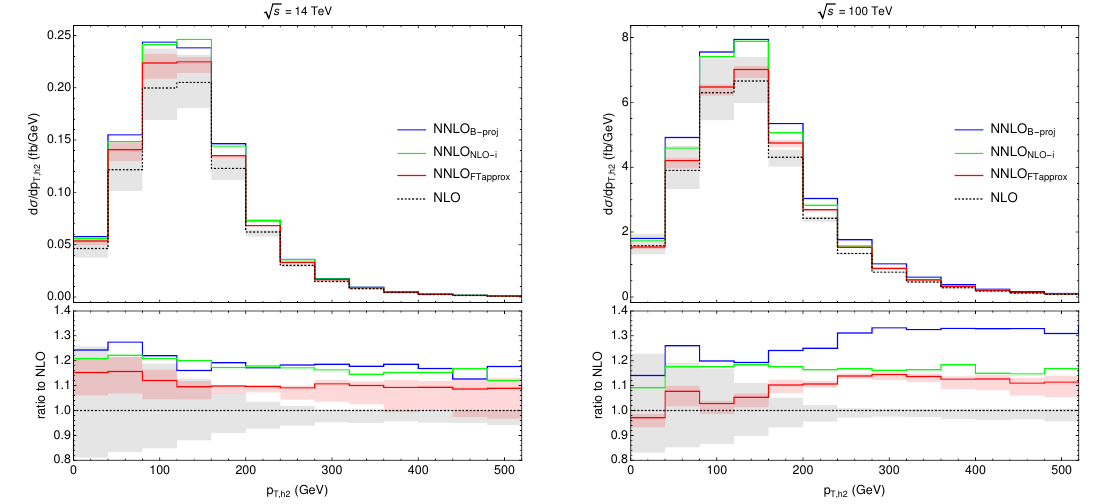
Figure 7 . Transverse momentum distribution for the softer Higgs boson at 14 TeV (left) and 100 TeV (right).